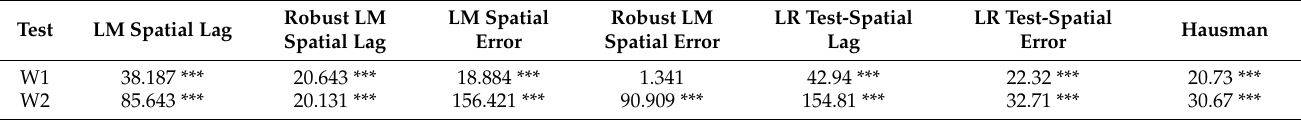
Table 8. Spatial Durbin model results with W1.